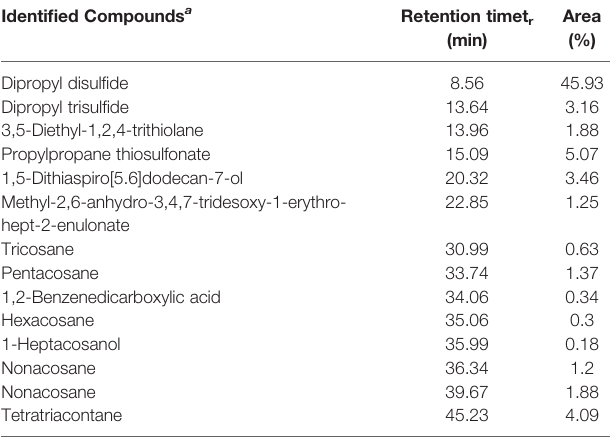
TABLE 1 | Compounds identi fi ed in Allium cepa bulb extract. Identi fi ed Compounds